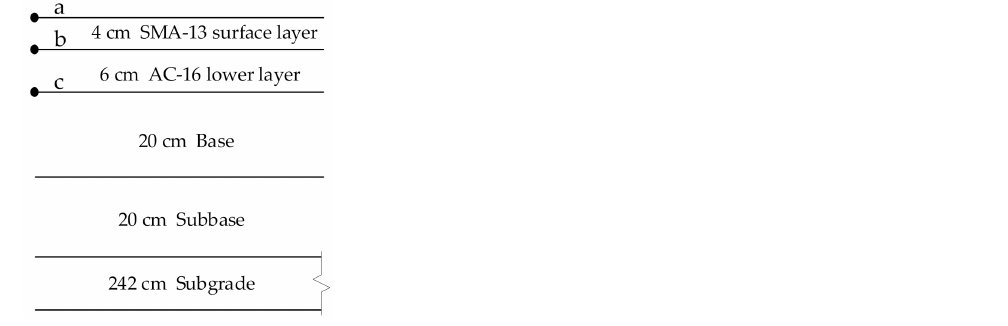
Figure 2. Pavement structure and analysis points. where a is the surface position of surface layer, b is the bottom position of surface layer, c is the bottom position of lower layer.